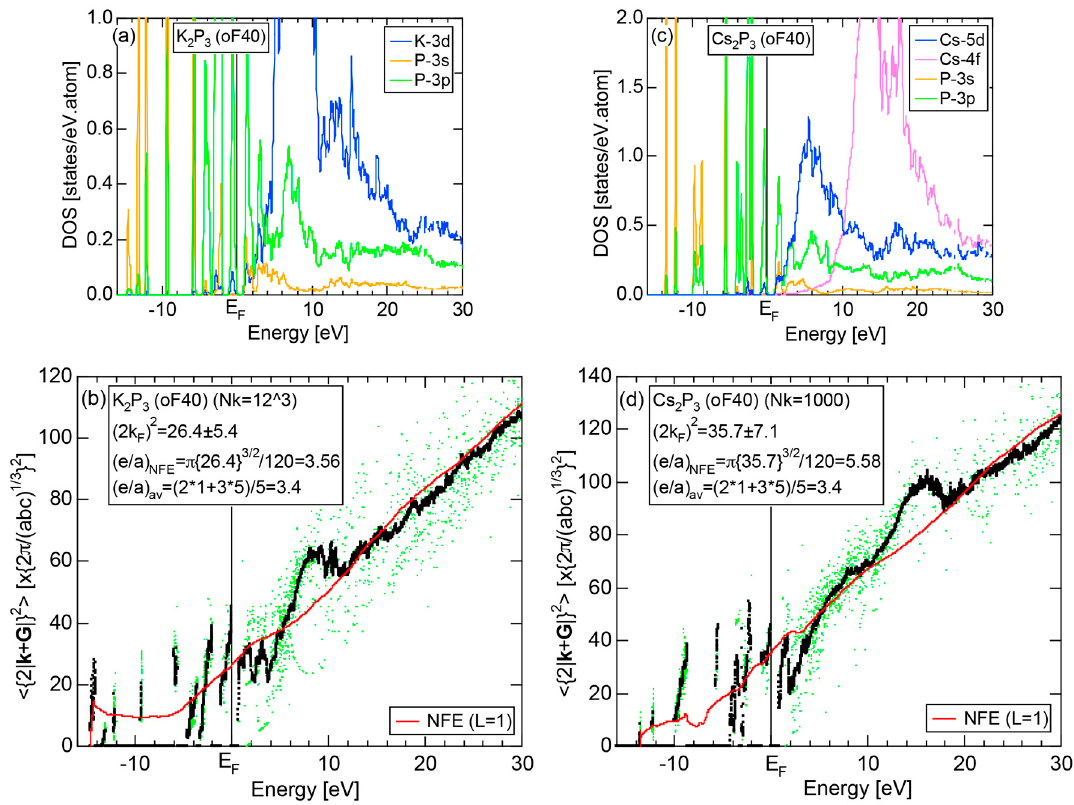
Figure 78. ( a ) K-3d, P-3s, P-3p pDOSs and ( b ) Hume-Rothery plot for K 2 P 3 (oF40). ( c ) Cs-5d, Cs-4f, P-3s, P-3p pDOSs and ( d ) Hume-Rothery plot for Cs 2 P 3 (oF40). See captions of Figure 19 (b) for symbols in (b) and (d) [11,12].